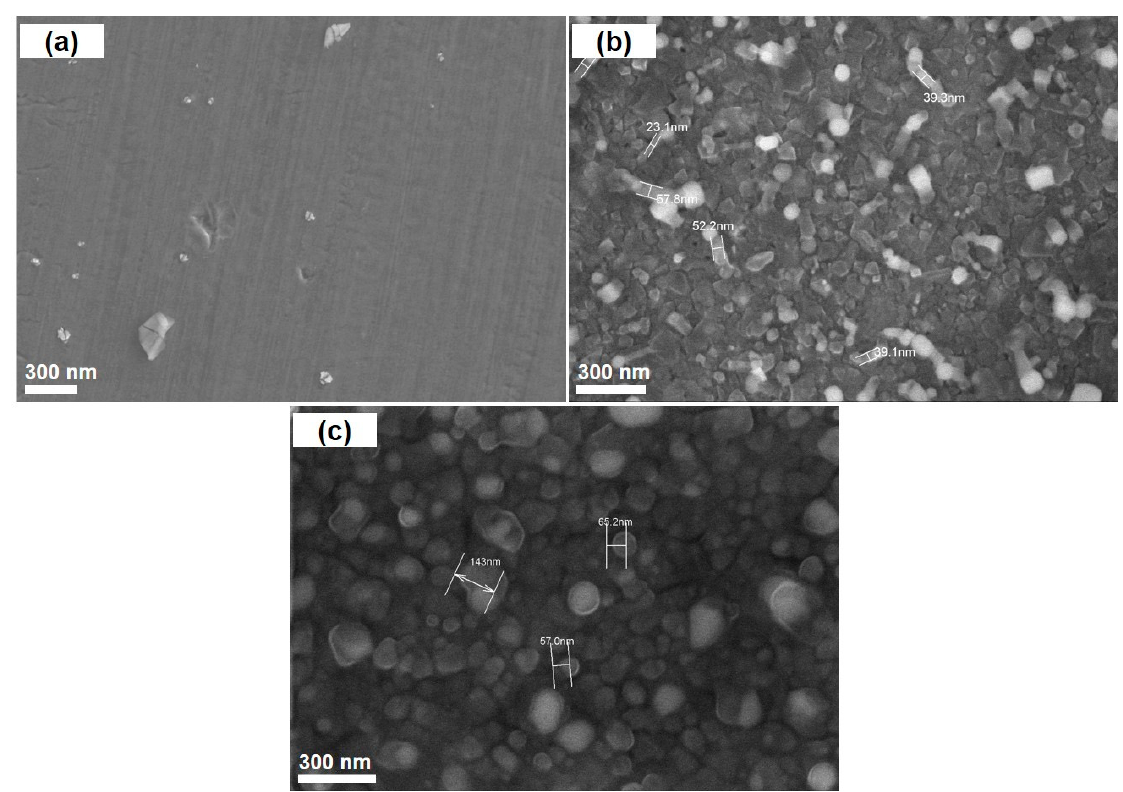
Figure 2. SEM images of the synthesized carbon nanotubes (CNTs) at different pretreatment temperatures: ( a ) at 750 °C for 10 min; ( b ) at 850 °C for 10 min; ( c ) at 950 °C for 10 min.